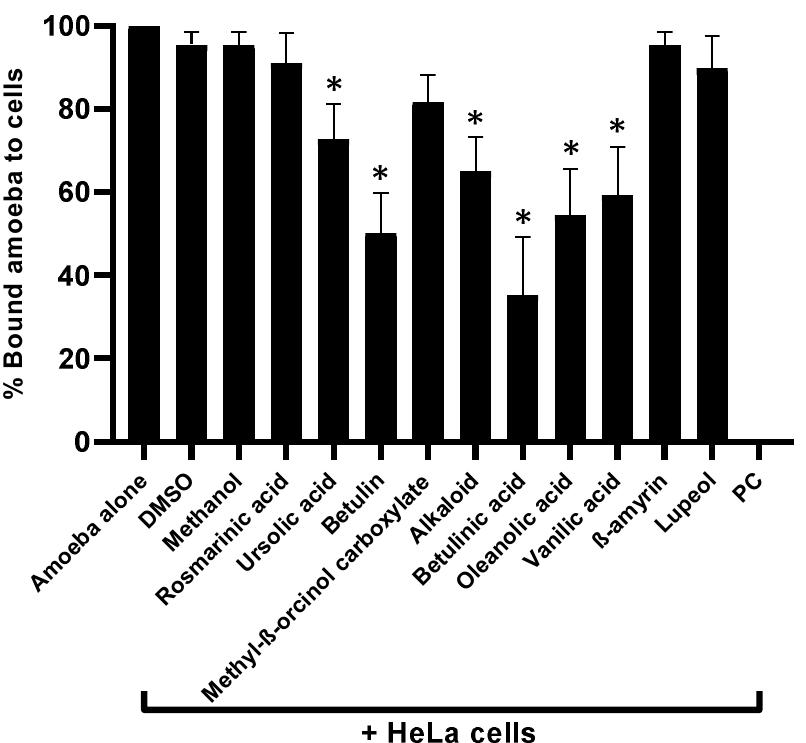
Figure 3. Compounds significantly blocked the A. castellanii binding to human cells. Adhesion assays were carried out to examine whether A. castellanii interact with human cells. p values were determined using two-sample t -test, two-tailed distribution, (*) is < 0.05. The data are represented as the mean ± standard error of three independent experiments performed in duplicate.